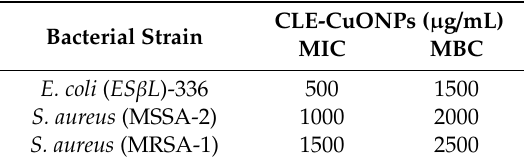
Figure 5. Antibacterial activity assessment. ( A ) shows assessment of antibacterial activity of CLE alone and CLE-CuONPs by a well diffusion assay. A volume of 100 μL CLE (10%) was taken as control. Each histogram represents the mean ± SD of two independent experiments done in triplicate; ( B ) representative culture plates of (i) Gram-negative ESβL producing E. coli- 336, (ii) Gram-positive methicillin-sensitive MSSA-2, and (iii) and methicillin-resistant MRSA-1 exhibiting zone of growth inhibition at (a) 10% CLE, and (b) 500, (c) 1000, (d) 1500 and, (e) 2000 μg/mL of CLE-CuONPs after 24 h of exposure.